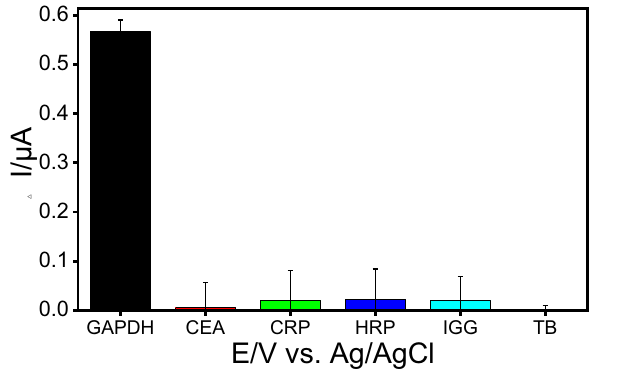
Figure 5. Selectivity study of the GAPDH electrochemical immunosensor in the presence of other proteins (CEA, CRP, HRP, IGG, TB) under 1 ng/mL conditions.